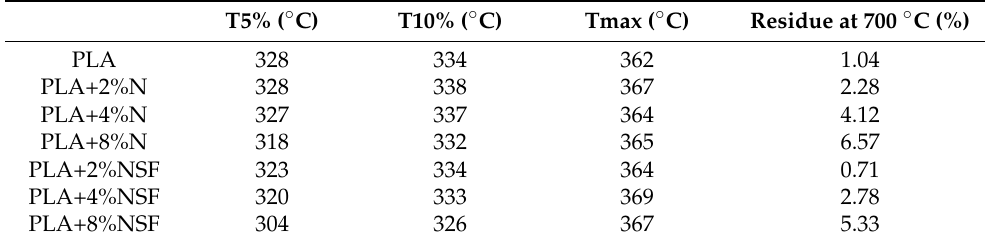
Table 4. Degradation temperatures and residue at 700 °C of PLA and PLA nanocomposites.